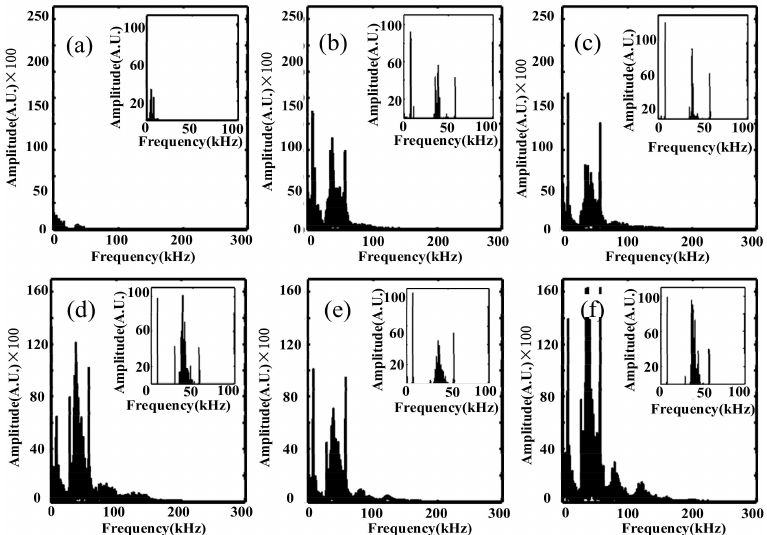
Figure 11. Frequency waveform of PD signals at different positions. ( a ) No partial discharge event. The sensing probe was placed ( b ) on the top, ( c ) in the front, ( d ) behind, ( e ) on the left side and ( f ) on the right side of the discharge protection hood. The zoomed figures in every sub-figure show the frequency distribution